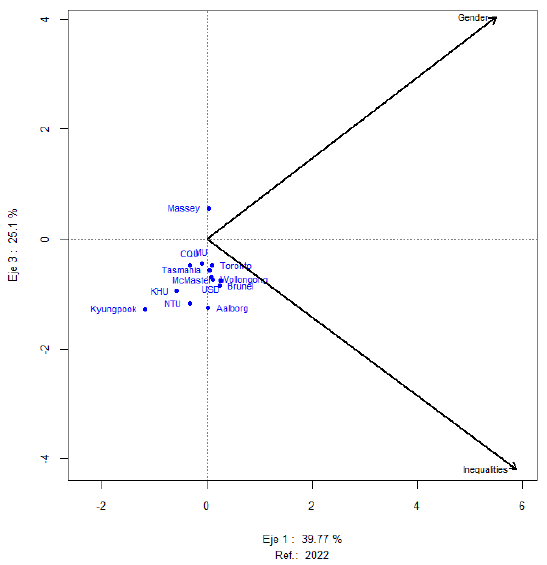
Figure 2. Factor representation HJ biplot for The Impact Rankings (2022), plane 1–3.